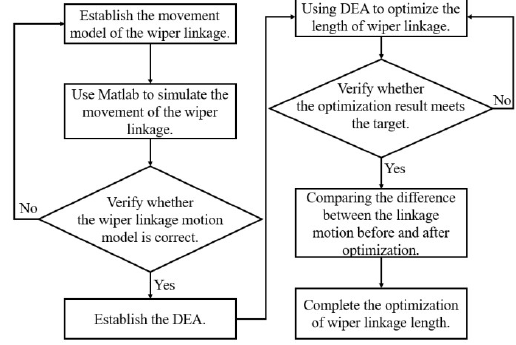
Figure 3. Flowchart of our research